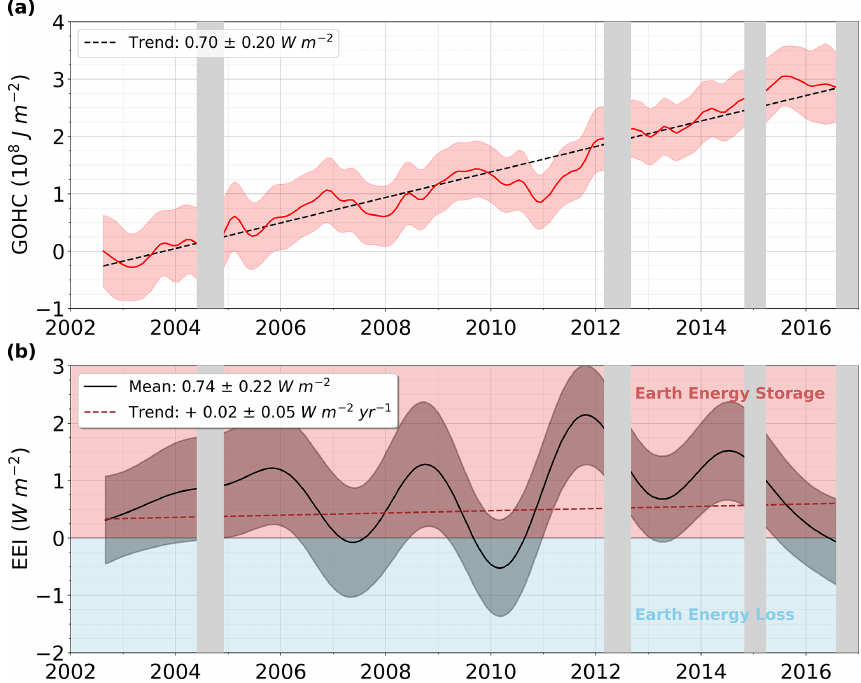
Figure 3. Times series of (a) global ocean heat content (GOHC) change and (b) Earth energy imbalance (EEI) from a space geodetic approach (MOHeaCAN v2.1) over the August 2002–August 2016 period. Data spatial distribution considered for the GOHC change computation is presented in Fig. 1. The uncertainty envelopes are superimposed (at 1-sigma). Uncertainties on trends and means are reported within a 90% confidence level (1.65-sigma). The GOHC change curve is shifted along the ordinate axis to start from the origin in 2002. Grey areas correspond to data gaps in the gravimetry product used for the space geodetic GOHC